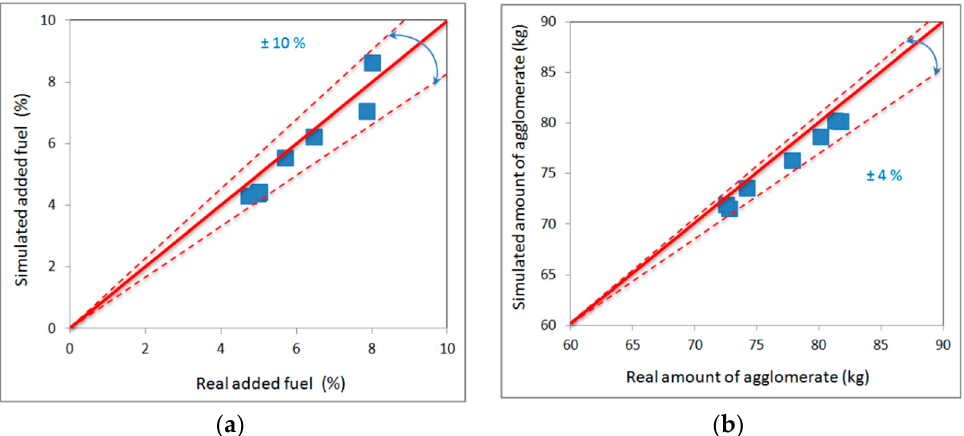
Figure 8. Comparison between the real and simulated added fuel for sintering ( a ) and real and simulated amount of the agglomerate ( b ).